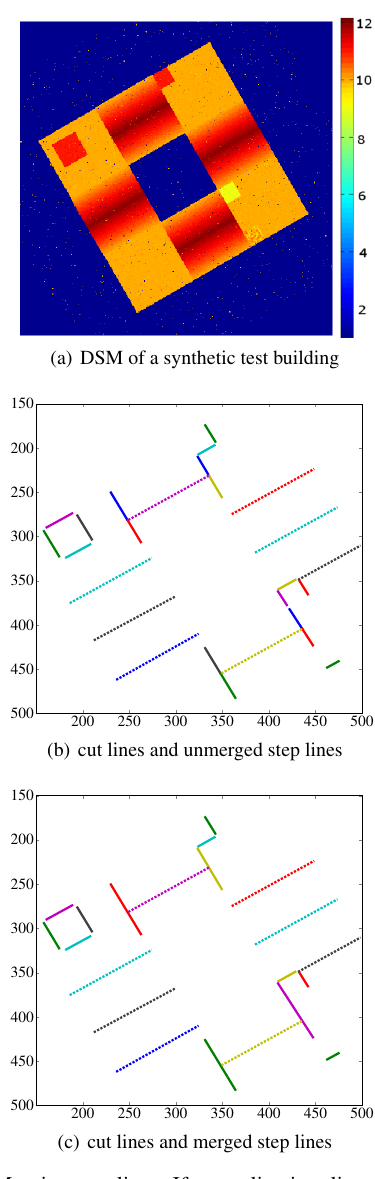
Figure 2. Merging step lines: If a step line is splinted (e.g. upper right, light green and blue), they get merged. Cut lines (dotted) are not merged.